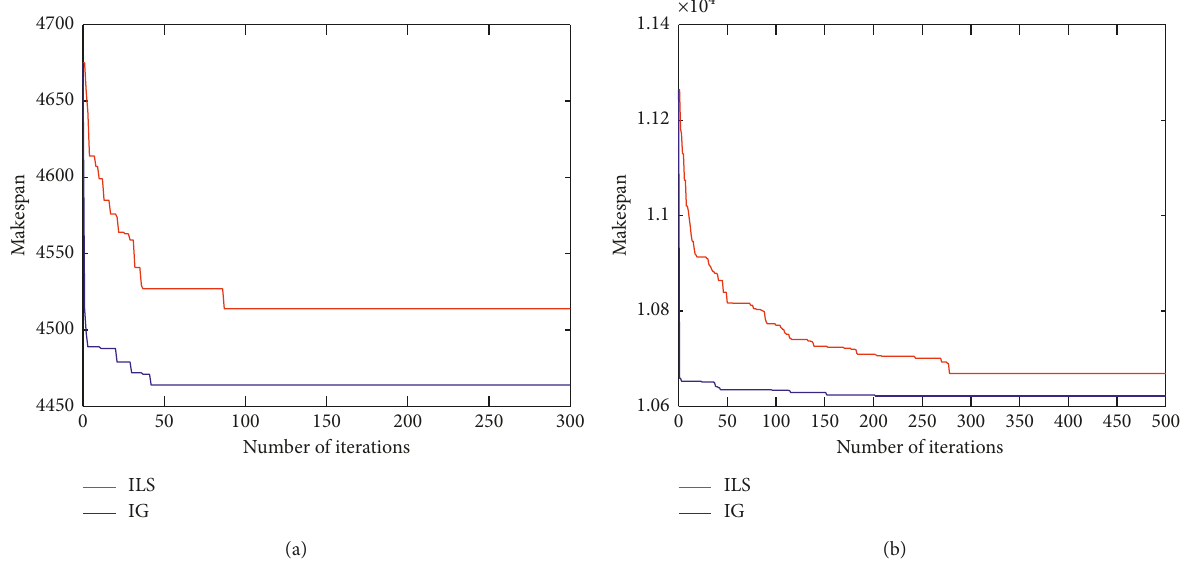
Figure 5: Makespan vs. number of iterations for n � 40 and m � 10 (a) and for n � 40 and m � 20 (b).